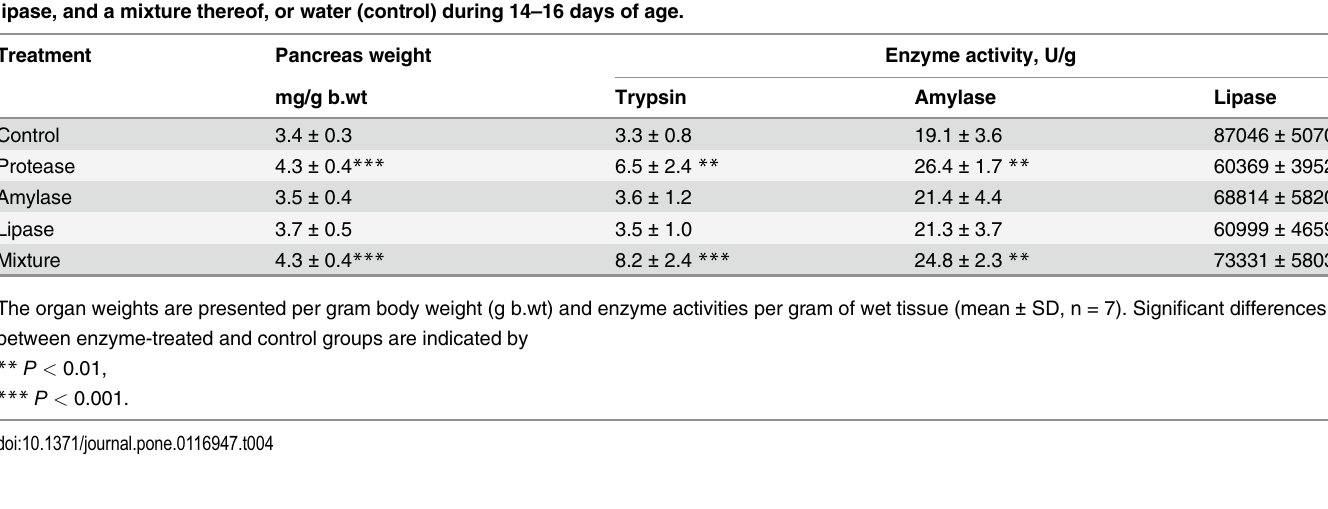
Dose-response effects of the protease Oro-gastric feeding with different doses of the microbial-derived protease demonstrated in- creasing growth of the SI, being significant for the two highest doses (0.5 and 0.25 mg/g b.wt), i . e ., increased length and weight of the SI and weight of the cecum (Table 5). Similarly, the liver and pancreas weights were increased and the stomach pH was decreased with the highest dose (0.5 mg/g b.wt) as compared to the control pups. The morphological analyses of the distal SI for the proportion of adult-type, non-vacuolated enterocytes on the villi, showed a dose- dependent increase, from about 20% in the controls to almost 100% for the highest protease dose given (Fig. 4).